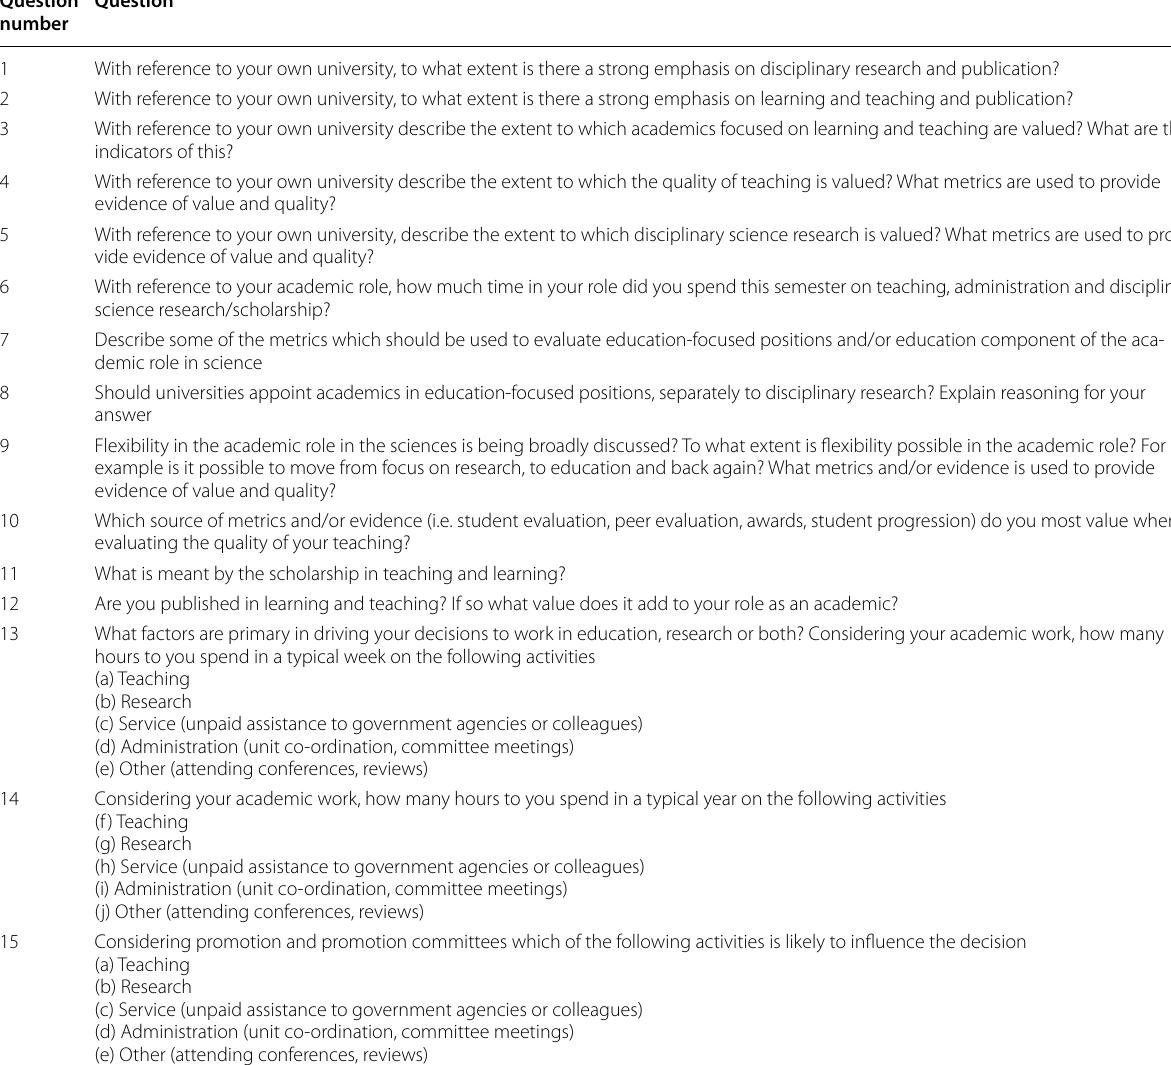
Table 2 Questions asked to academics in semi-structured